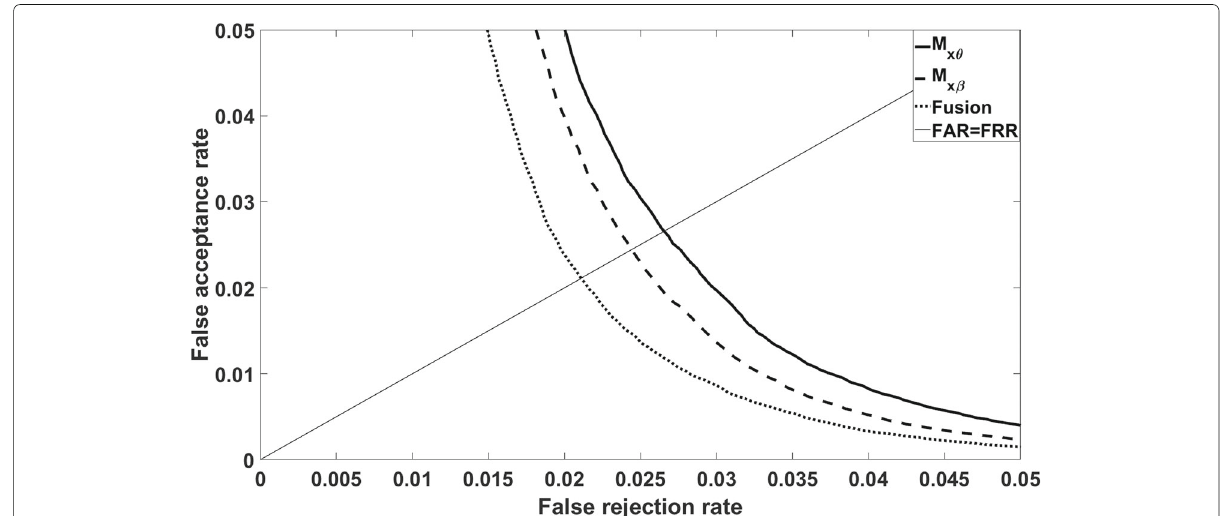
Fig. 12 Performance of M x θ and M x β individually, and of their fusion. MCYT database; enrollment method E1; analog domain